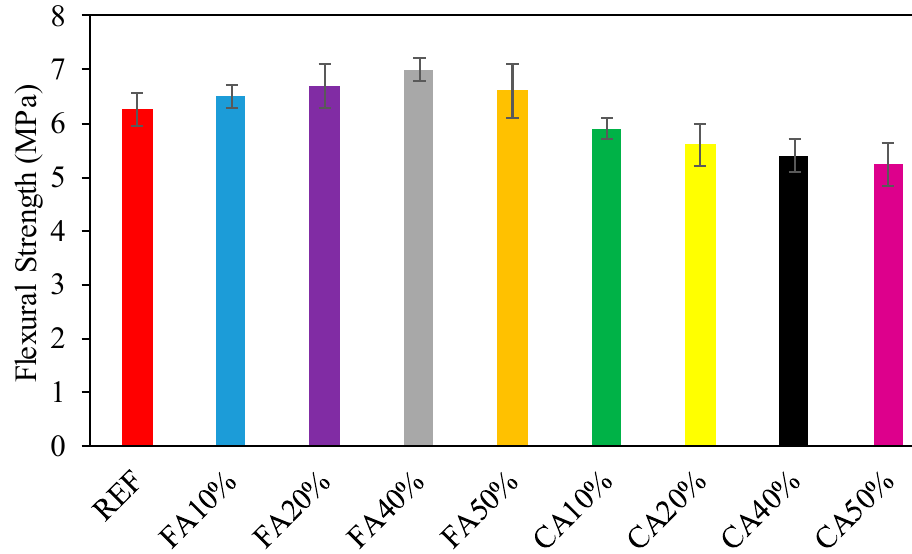
Figure 5. Consequences of FS.